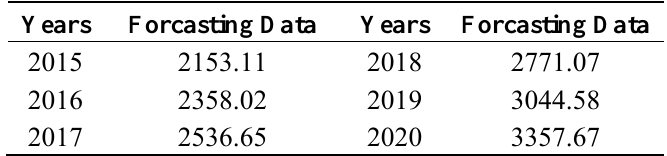
Table 13. Modified forecast of China’s biofuel production for 2015 to 2020 using the DGFM (1,1)